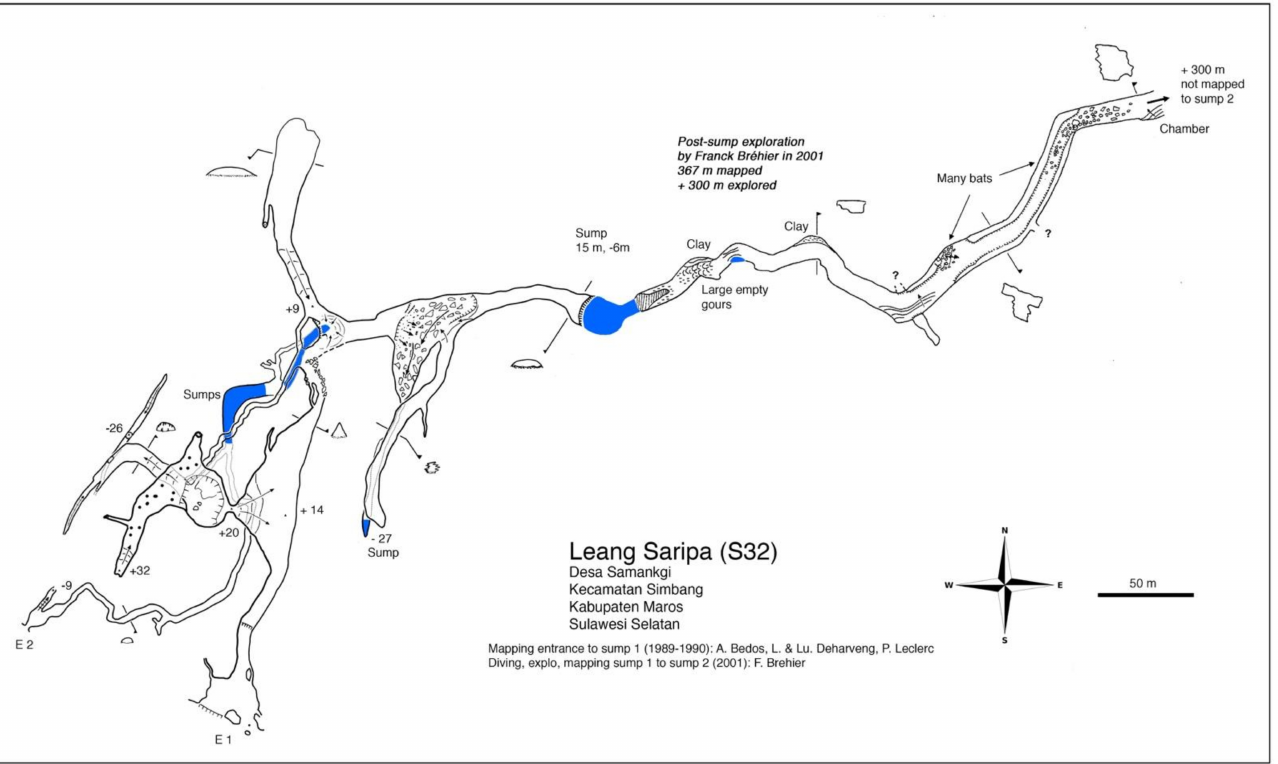
Figure 4. Map of Leang Saripa, synthesis after